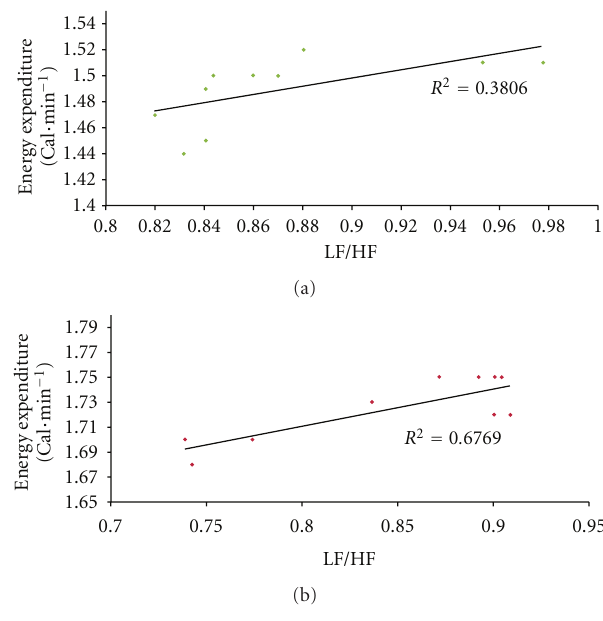
Figure 1: Correlation of low-frequency/high-frequency spectral power of heart rate variability with resting energy expenditure. Linear regression for low-frequency/high-frequency (LF/HF) heart rate variability spectral power computed from fast Fourier trans- form analysis of electrocardiogram RR intervals for ten healthy 18–20-year-old African American males during 20min trials of uncontrolled breathing (a) and paced breathing at 0.2Hz (b) after metabolic provocation with a 900Cal test beverage. R 2 = . 38; P < . 05 and . 68; P < . 01, 8 df,